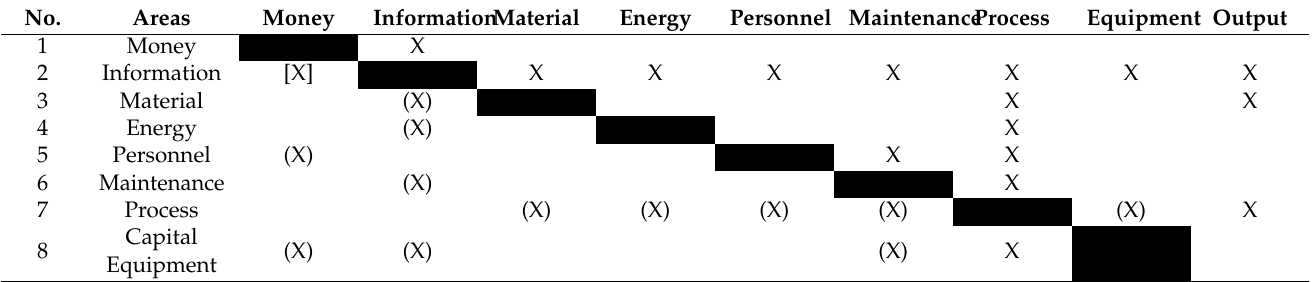
Table 1. Interrelationships among